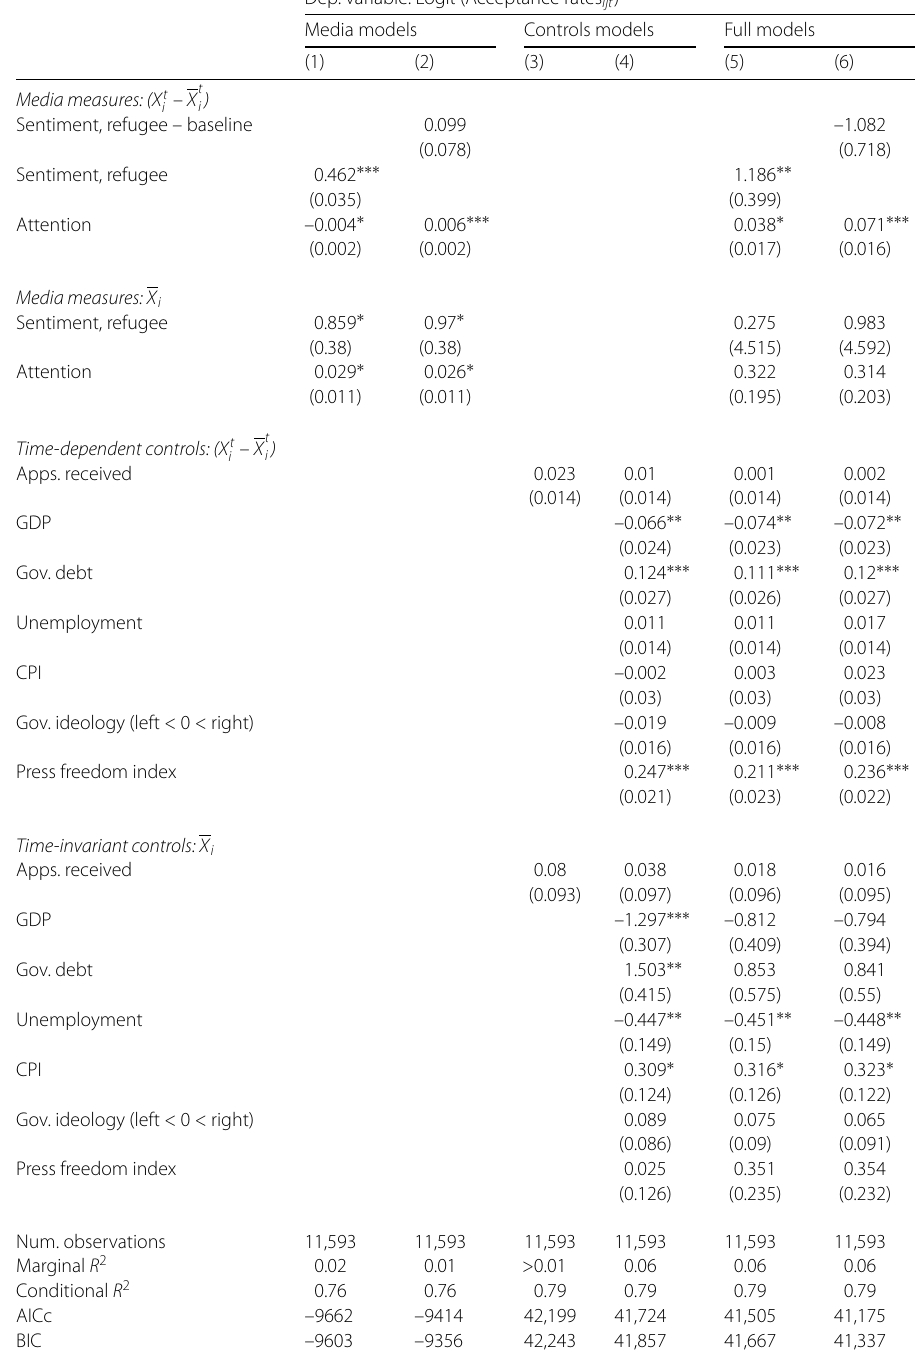
Table 1 In-sample results. Regression results for asylum acceptance rates considering public debate in the media and economic indicators as explanatory variables. R 2 values are as in [66]. Coefficients of public debate variables represent logit-logit marginal effects. Coefficients of control variables represent % change in odds with respect to 1 standard deviation change in variable. Small number in parentheses below estimates represents standard